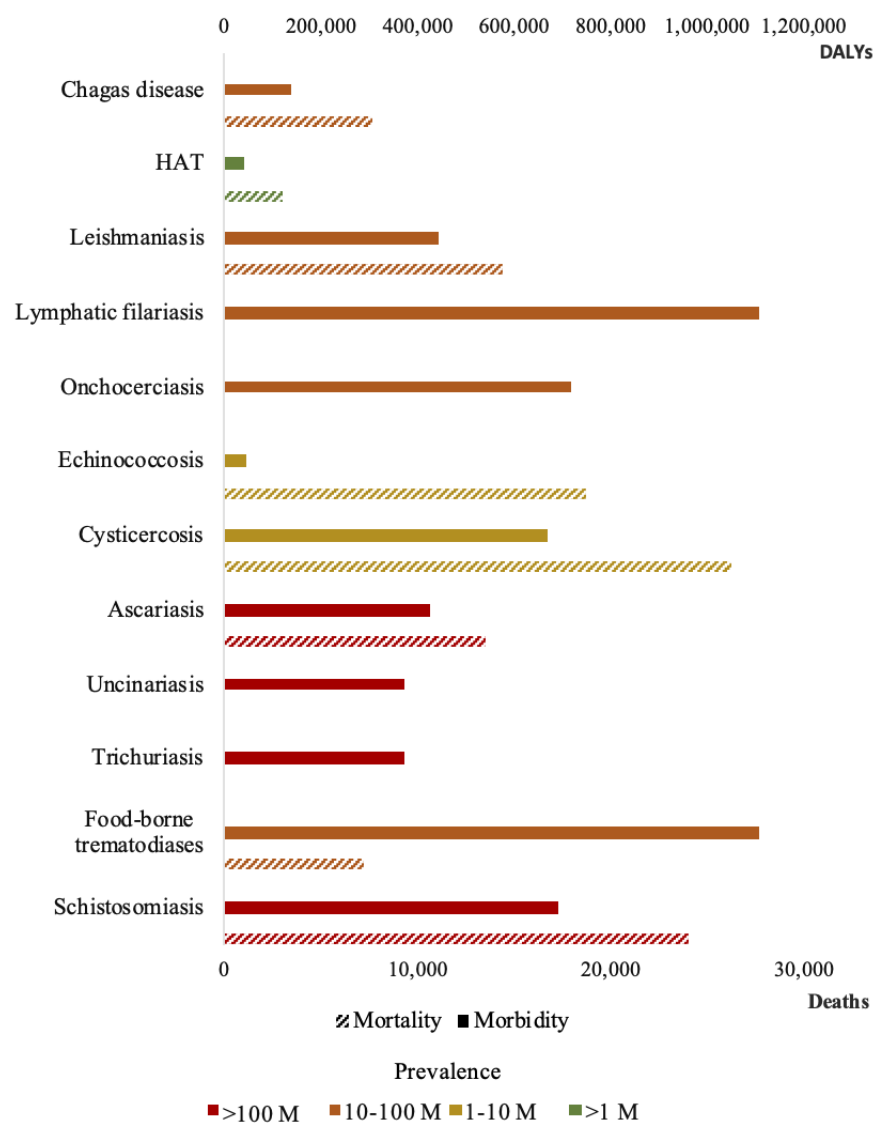
Figure 1. Estimated burden of parasite-caused Neglected Tropical Diseases (NTDs). Solid bars represent disability adjusted life years (DALYs) data, obtained from Kyu et al. [3]. Cross-lined bars represent mortality data, obtained from Global Health Estimates (GHE) 2016 [6]. Color of the bars represents prevalence values (referred as M, million people), obtained from Hotez et al.